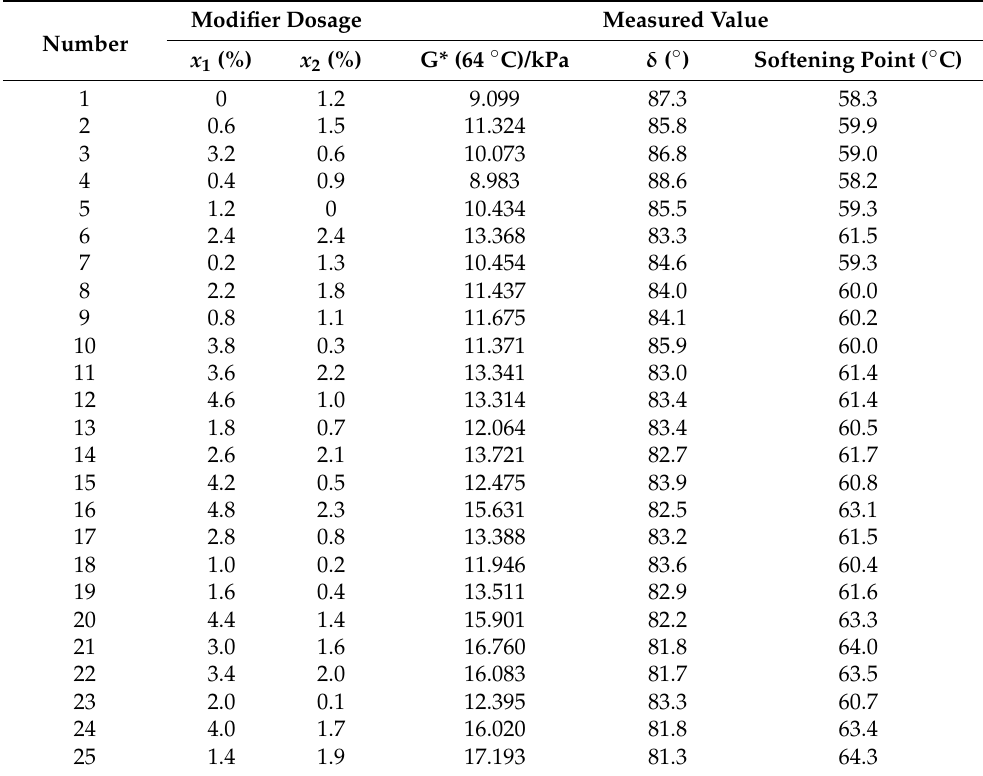
Table 6. Opt LHD experimental design and results.